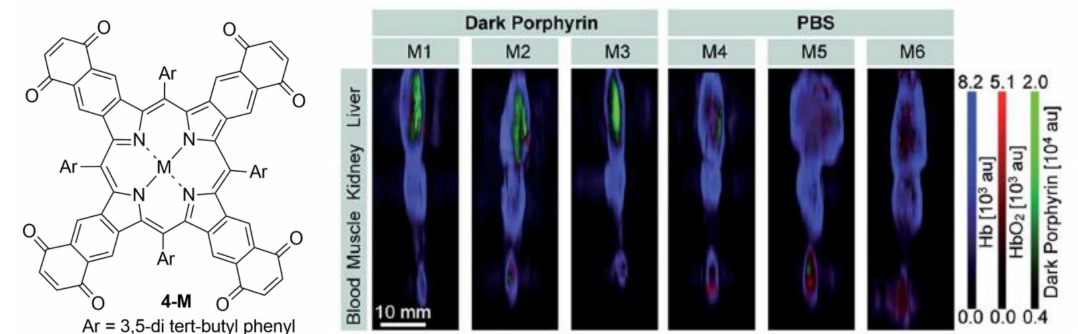
Figure 5. Left: Structure of the quinone-fused “black” porphyrin ( 4-M ); right: evaluation of a NIR-absorbing (M = Zn) derivative as contrast agent for in vivo photoacoustic imaging in healthy mice (multispectral optoacoustic tomography (MSOT) spectral unmixing of the 4-Zn signals from the blood; no 4-Zn remained in blood after 1 h). Reproduced from Reference [72] with permission from the Royal Society of Chemistry.